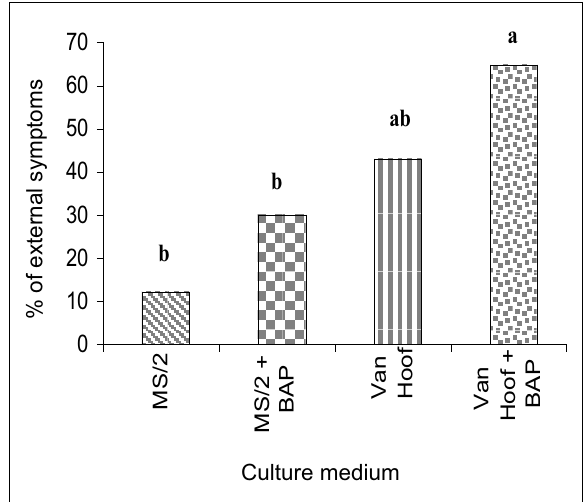
Fig. 1. Effect of nutrient variations and BAP addition on grape virus expression. Means with different letters show significant difference at P ≤ 0.01 using Tukey